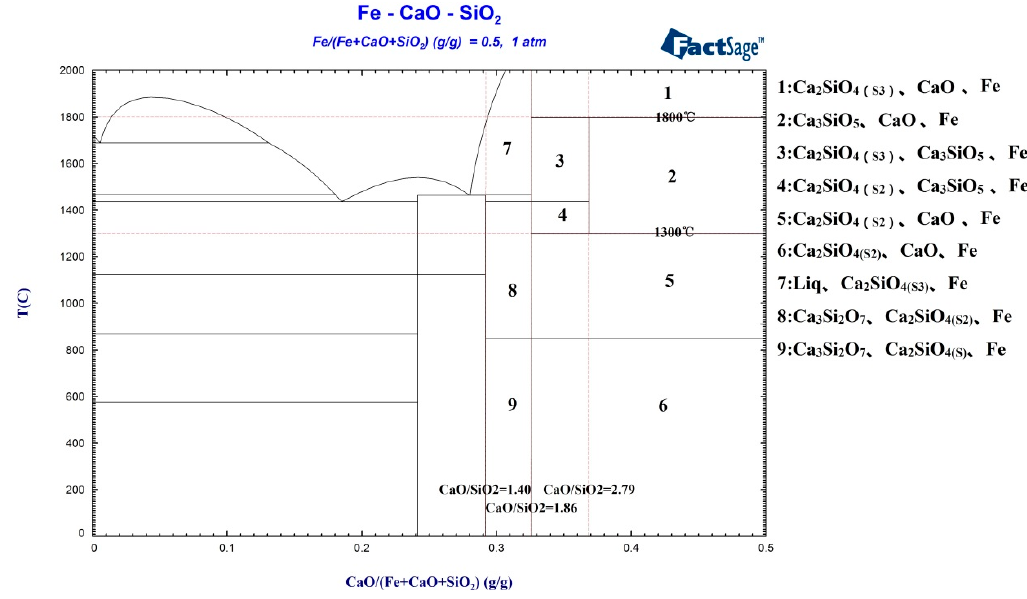
Figure 4. Phase diagram of the Fe-CaO-SiO 2 ternary system.